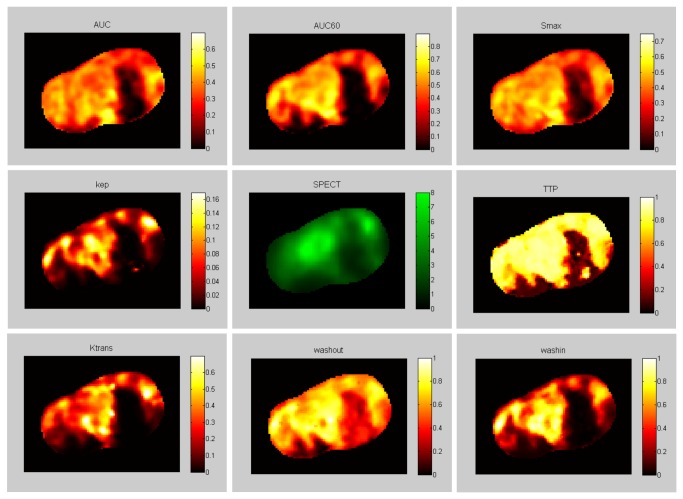
Visualization of the correspondence between SPECT-peptide uptake and DCE-MRI-derived parameters.Color coded images of SPECT peptide uptake (in Bq) (green) and different DCE-MRI parameters (red) for one slice through the tumor. Clockwise starting from the top left: AUC, area under the whole curve; AUC60, area under the curve for the first 60 s; Smax, maximum enhancement; TTP, time to peak; wash-in, slope between the 10% point and the 90% point on the enhancement curve [19]; wash-out [19]; Ktrans (s-1) capillary transfer constant [20]; kep (s-1), contrast exchange rate [20]. All semi-quantitative parameters were normalized and TTP values were inverted for visualization purposes.